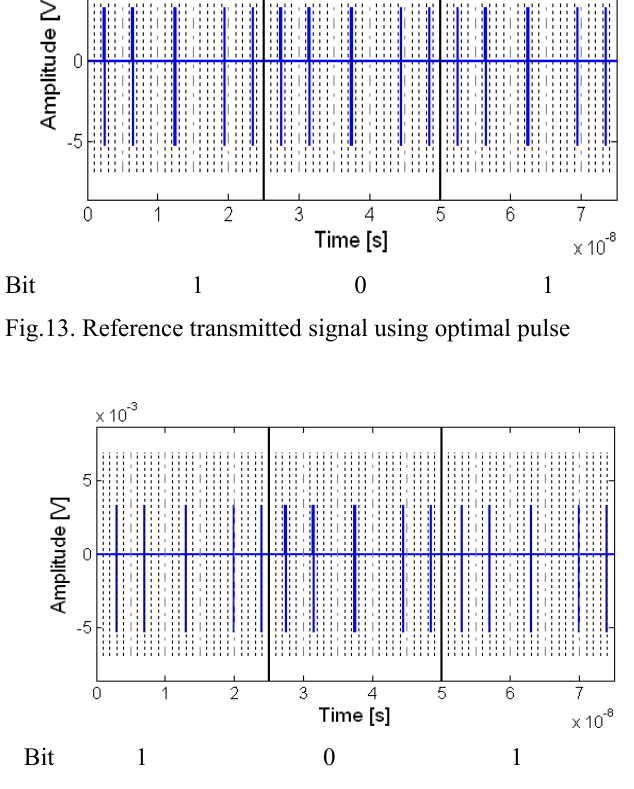
Fig.14. Transmitted signal using optimal pulse after